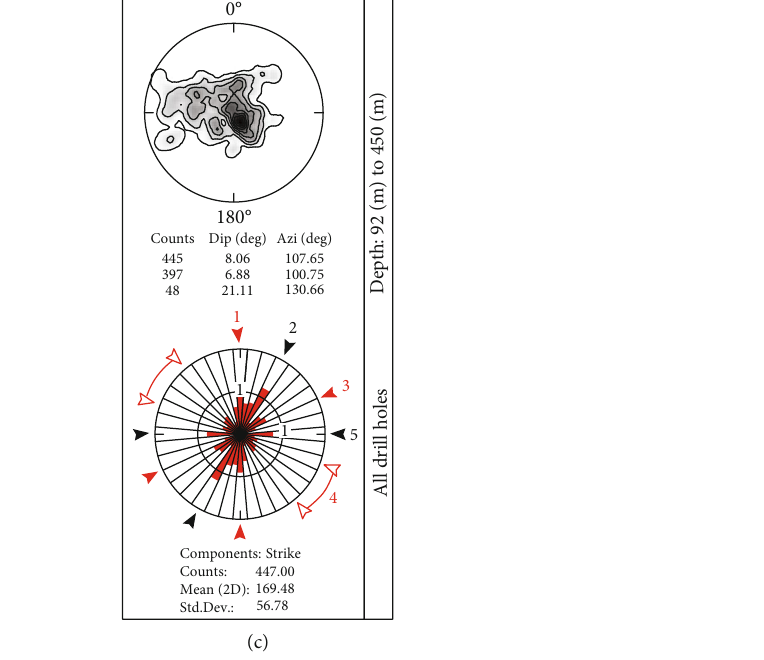
Figure 4: (a) Structural correlation of the upper graphite-rich interval (in grey) and DBSZ (in blue) through the drill holes S830A and S832. (b) ATV oriented data and structural interpretation of the correlated interval. (c) ATV oriented data on stereonets and rosacea plots compiled from all studied drill holes showing the main fault sets with red and black numbered arrows. Legend in Figure